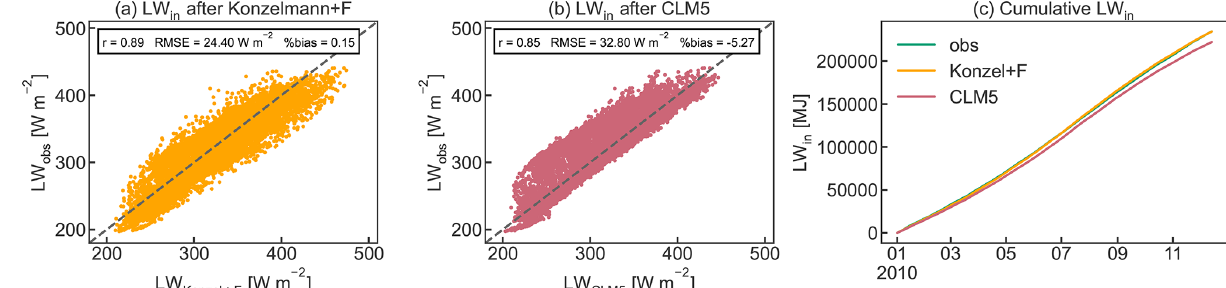
Figure B2. Comparison of observed LW in to the parameterization using (a) Konzelmann et al. (1994) according to Eq. (B2) and the cloud factor parameterization F(τ) and (b) the calculation procedure used in CLM5 as well as (c) cumulative observed and calculated LW in for 2010. Pearson’s r , RMSE, and percent bias are given as performance